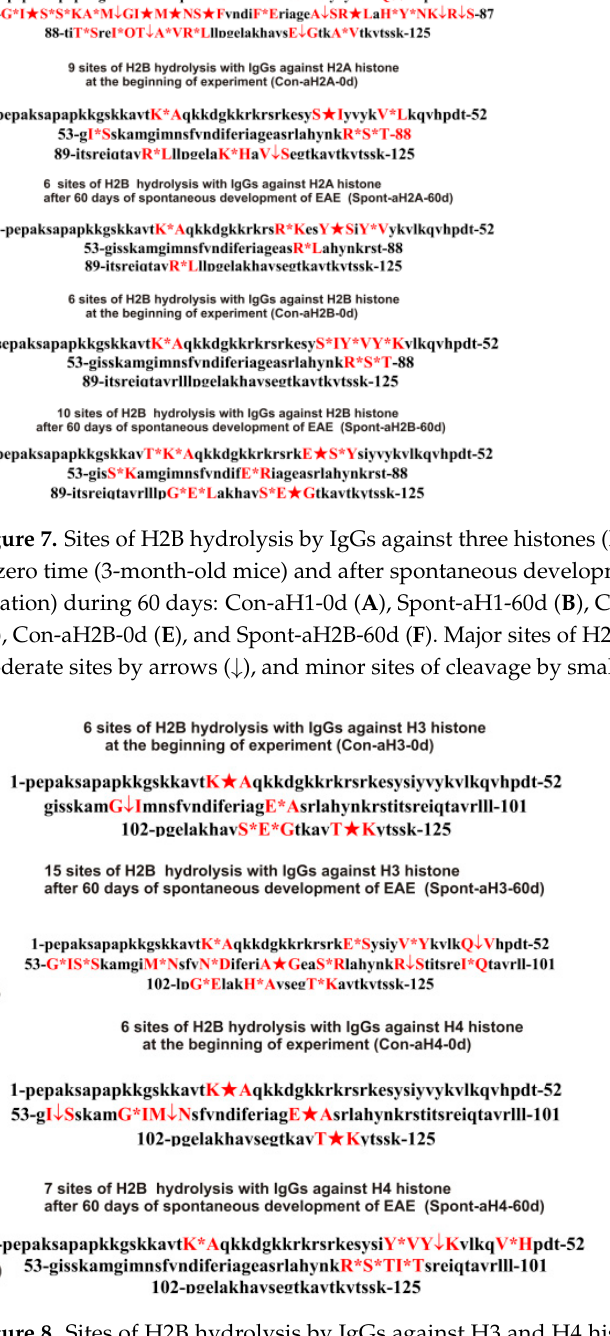
Figure 8. Sites of H2B hydrolysis by IgGs against H3 and H4 histones corresponding to zero time (3-month-old mice) and after spontaneous development of EAE (before mouse immunization) during 60 days: Con-aH3-0d ( A ), Spont-aH3-60d ( B ), Con-aH4-0d ( C ), and Spont-aH4-60d ( D ). Major sites of H2B cleavage are shown by stars ( ★ ), moderate sites by arrows ( ↓ ), and minor sites of cleavage by small stars (*).